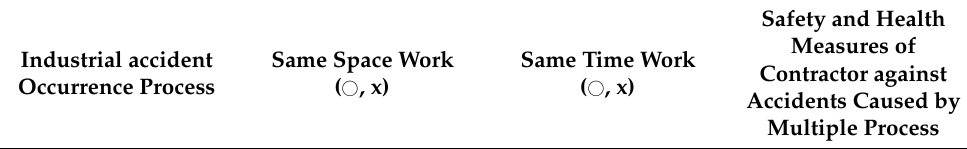
Table 9. Cases of struck accidents by the object by multiple processes in the